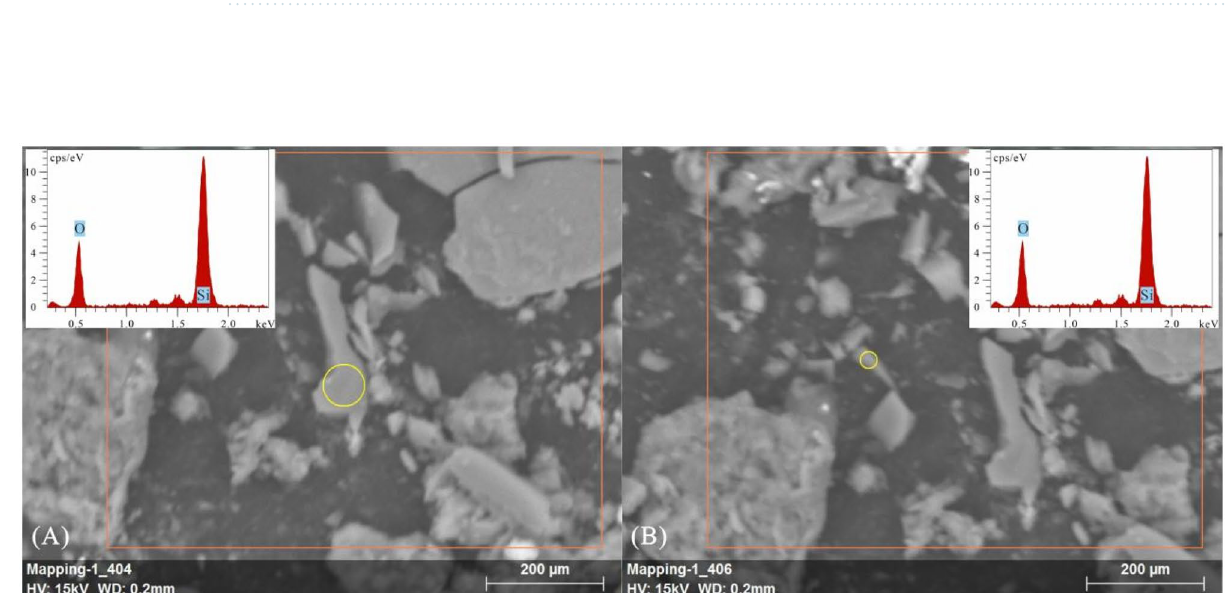
Figure 5. SEM images of quartz particles in sample MK-3-T. The sizes of the quartz, gulf corrosion, and cracks are shown.